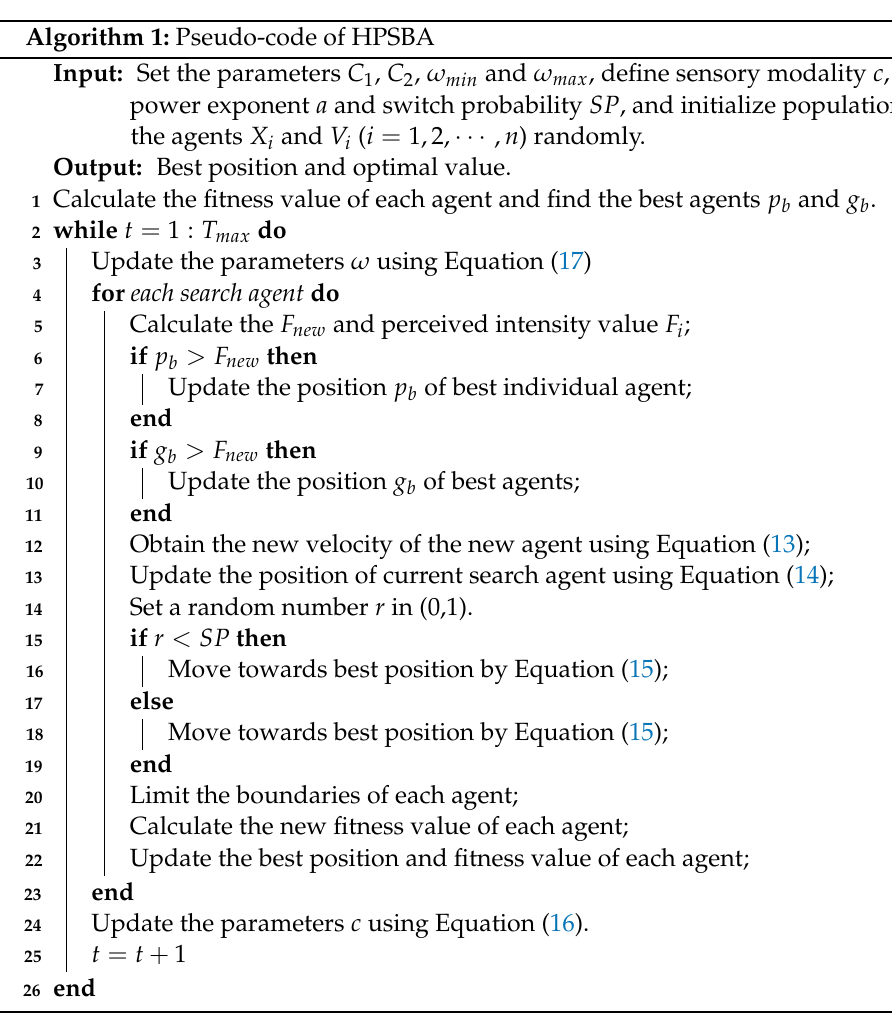
Algorithm 1: Pseudo-code of